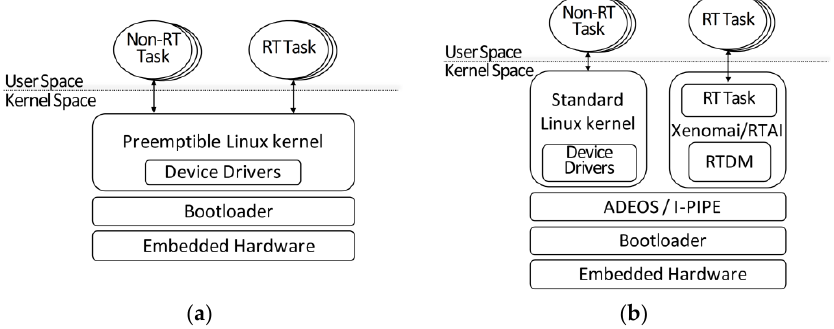
Figure 1. Classification of real-time embedded Linux systems: ( a ) fully preemptible kernel approach; ( b ) dual-kernel approach.